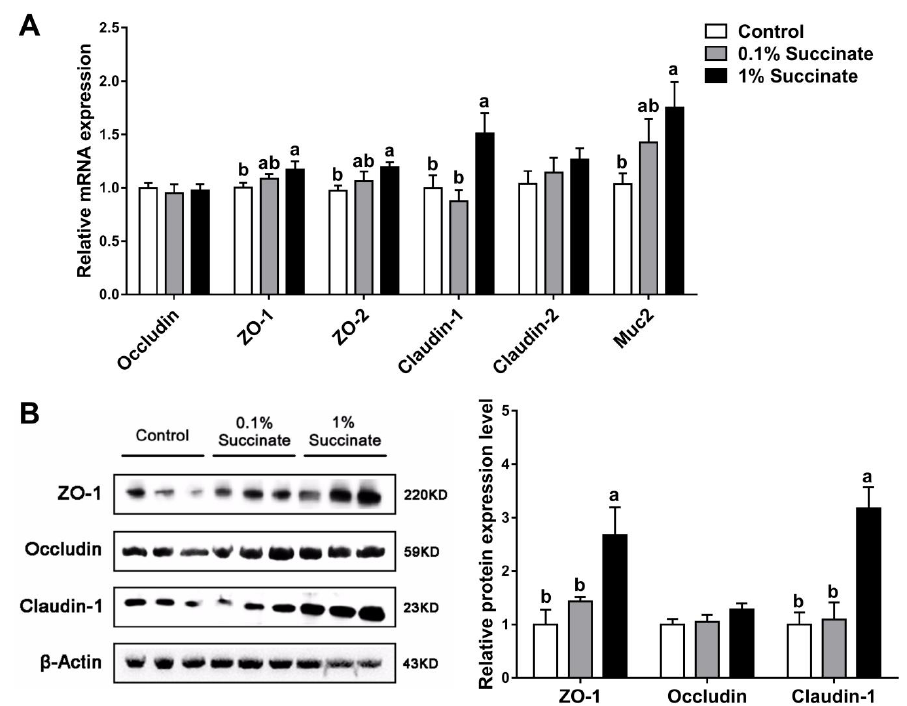
Figure 3. Effects of diet sodium succinate supplementation on the expression of barrier proteins in the jejunum of pigs: ( A ) relative mRNA levels and ( B ) the bands and relative band density of the proteins. Different superscript letters indicate significant differences between groups ( p < 0.05). Biomolecules 2019 , 9 , 486